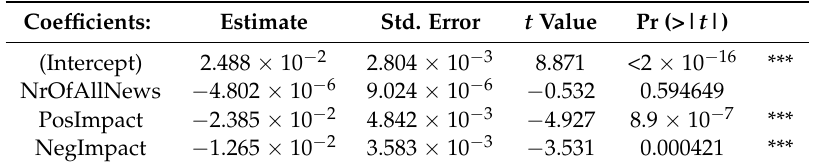
Table 3. Regression analysis for volatility of German mean bond spread difference. Residual standard